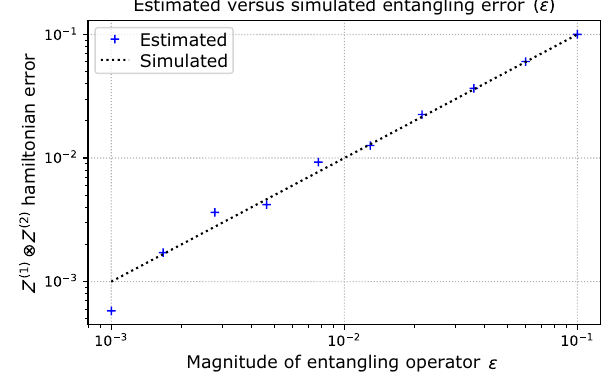
FIG. 7. Accuracy of the general crosstalk model’s entangling error estimate (simulation). The general crosstalk model is able to accurately estimate the magnitude of a simulated entangling Z ⊗ Z crosstalk error. Shown here is the magnitude of the estimate of this error term (extracted from the crosstalk-free model) for the idle gate versus the true magnitude of the entangling error.